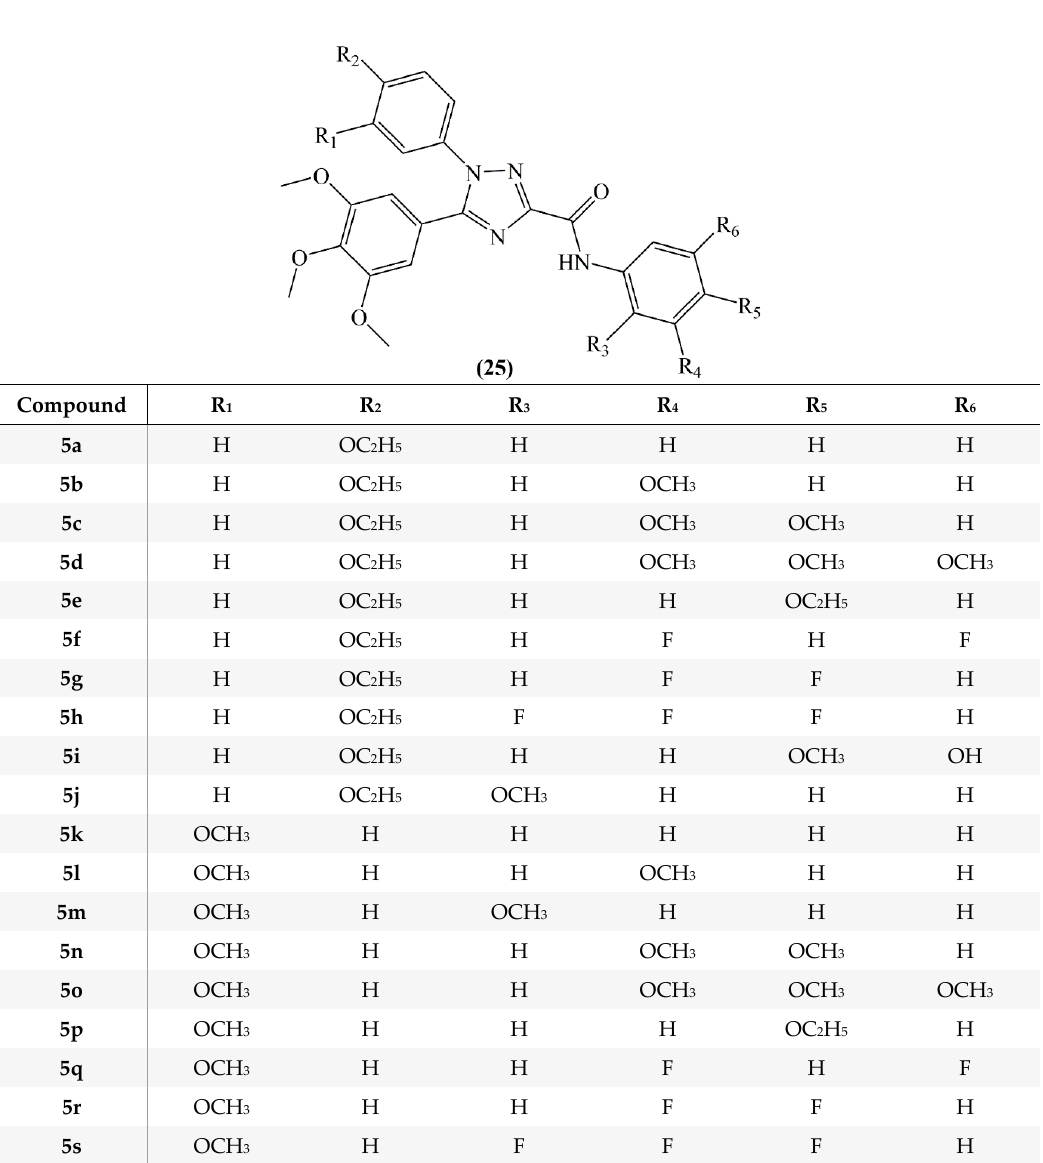
Figure 12. Structure of N -acylhydrazone analogs designed as comretastatin A4 derivatives (compounds 5a – 5s ).